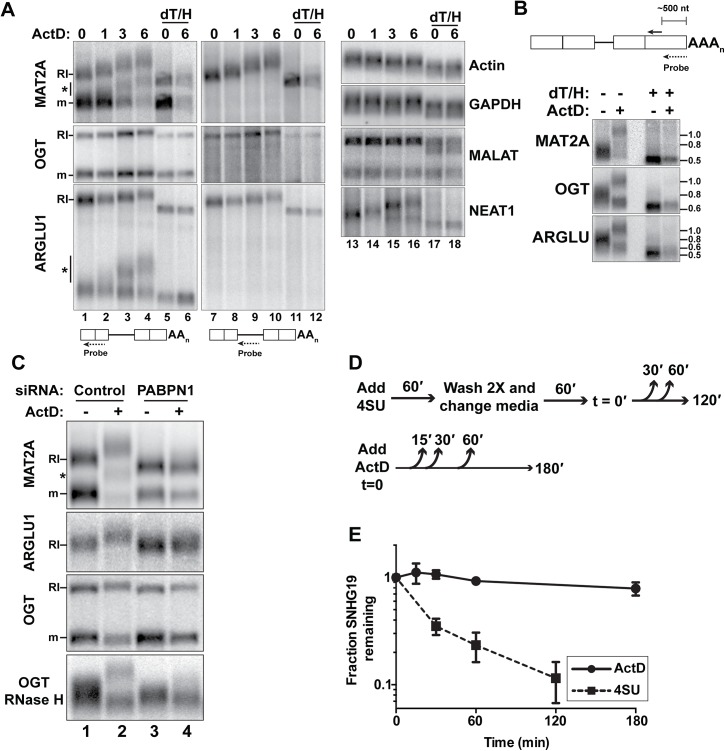
RI-RNAs are hyperadenylated upon ActD treatment.
(A) Northern blot of RNAs from cells treated with ActD and deadenylated with RNase H and oligo(dT) as indicated. The probes hybridized to exons (lanes 1–6, 13–18) or the RI (lanes 7–12). The asterisk marks RNAs that are fully spliced but hyperadenylated. (B) RNAs were cleaved ~500 nt from their poly(A) addition site and examined by northern blot with a probe to the 3´ cleavage product. ActD treatment was for 6 hrs. RNA markers (kb) are shown on the right. (C) Northern blots for specific transcripts using RNA from cells transfected with control or PABPN1 siRNAs +/- 6-hr ActD treatment. The bottom panel is an RNase H assay as in (B). (D) Scheme of the 4SU pulse-chase and ActD time courses. For the 4SU experiments, cells were washed and grown in label-free media for an additional hour prior to beginning the time course. This step was necessary to allow unincorporated 4SU in the cell to be depleted. (E) Decay profiles of SNHG19 as determined by 4SU or ActD.